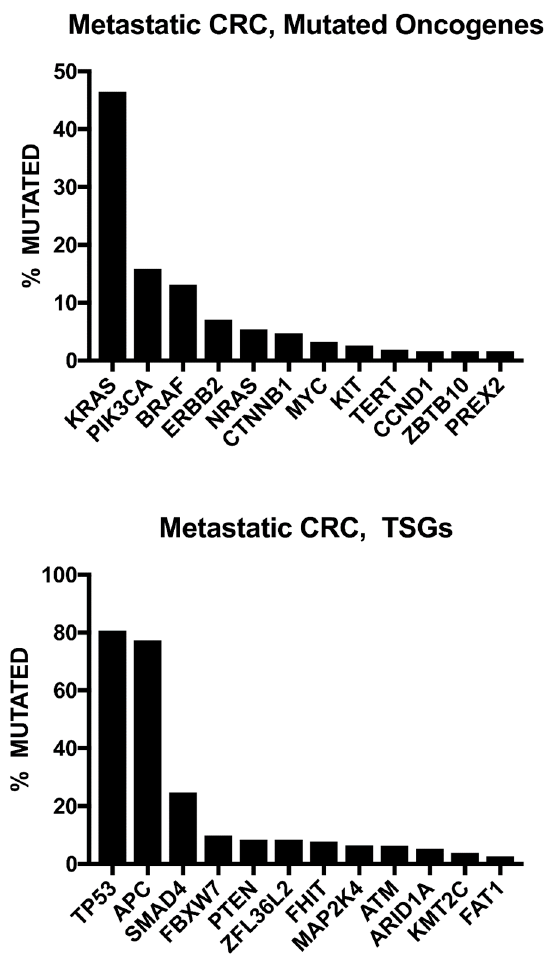
Figure 2. Frequent gene alterations based on wide-genome sequencing of 372 metastatic colorectal cancer (CRC) patients. Note: TSGs: tumor suppressor genes. Open Access Citation: Testa U, Castelli G, Pelosi E. Genetic Alterations of Metastatic Colorectal Cancer. Biomedicines . 2020;